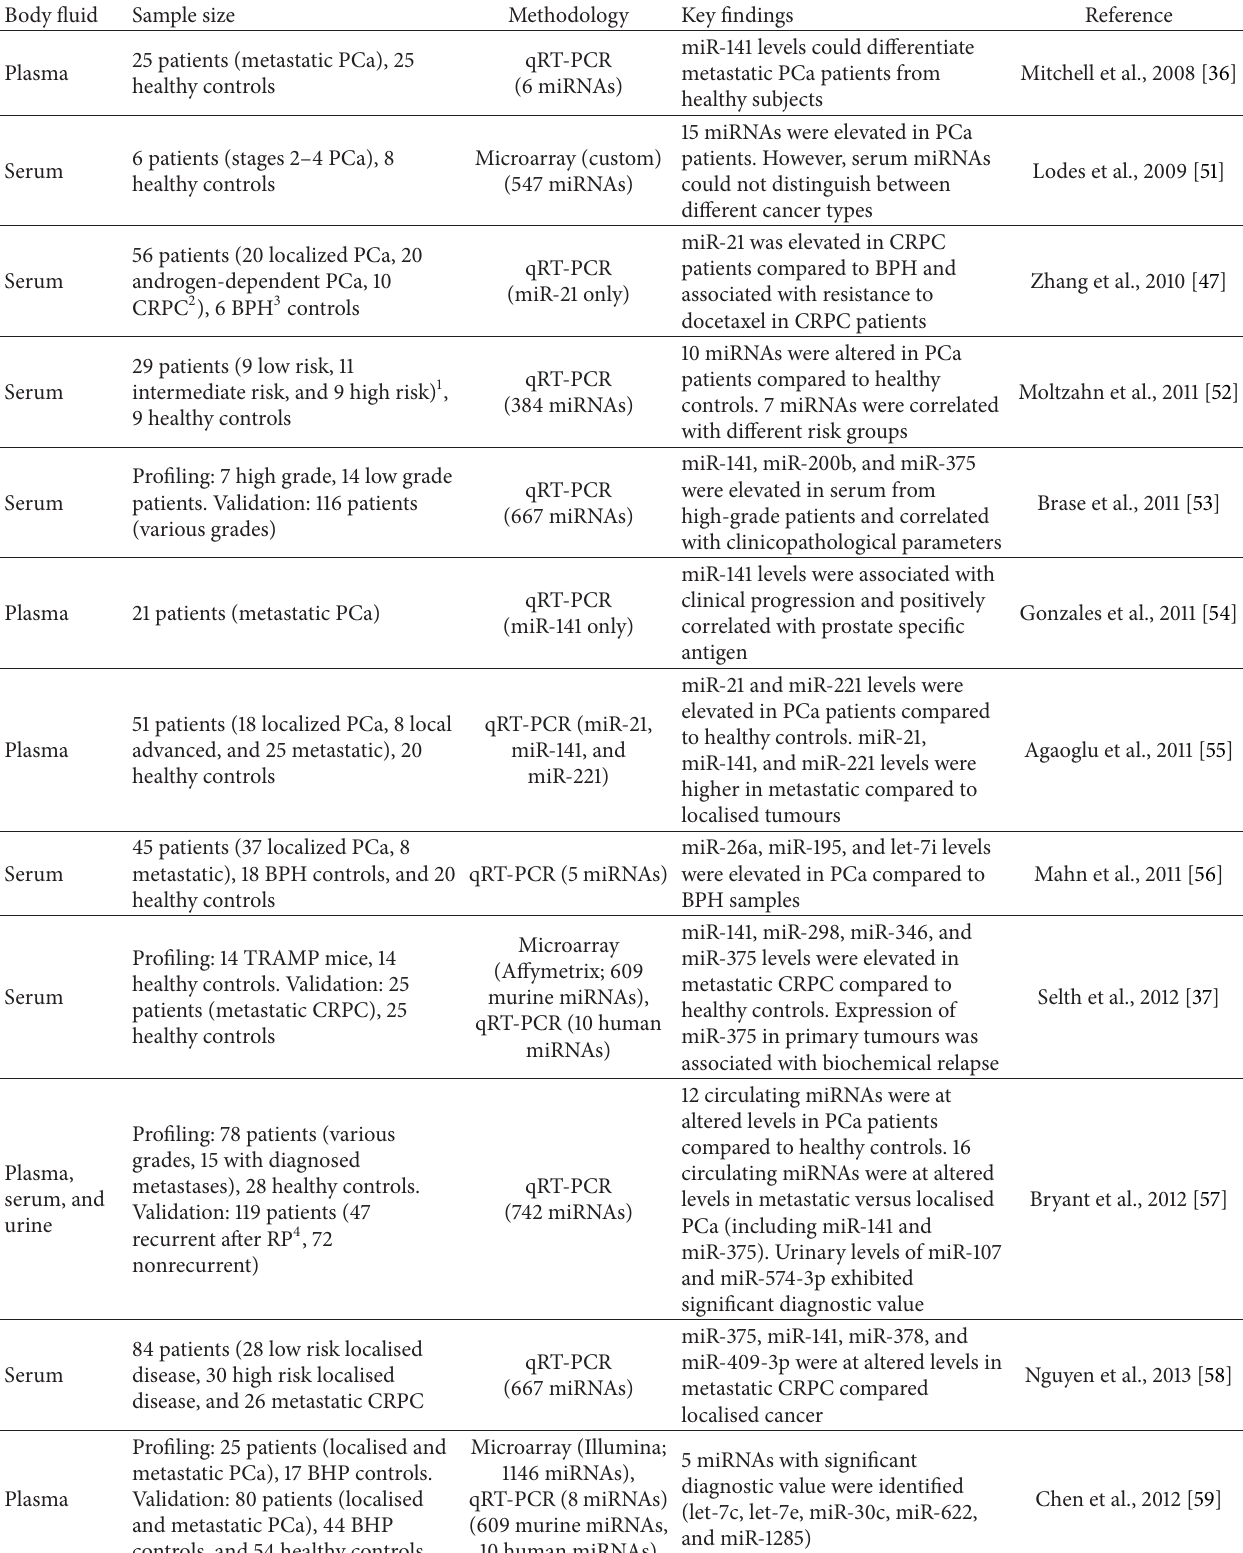
Table 1: Studies investigating the potential of circulating miRNAs as biomarkers of prostate